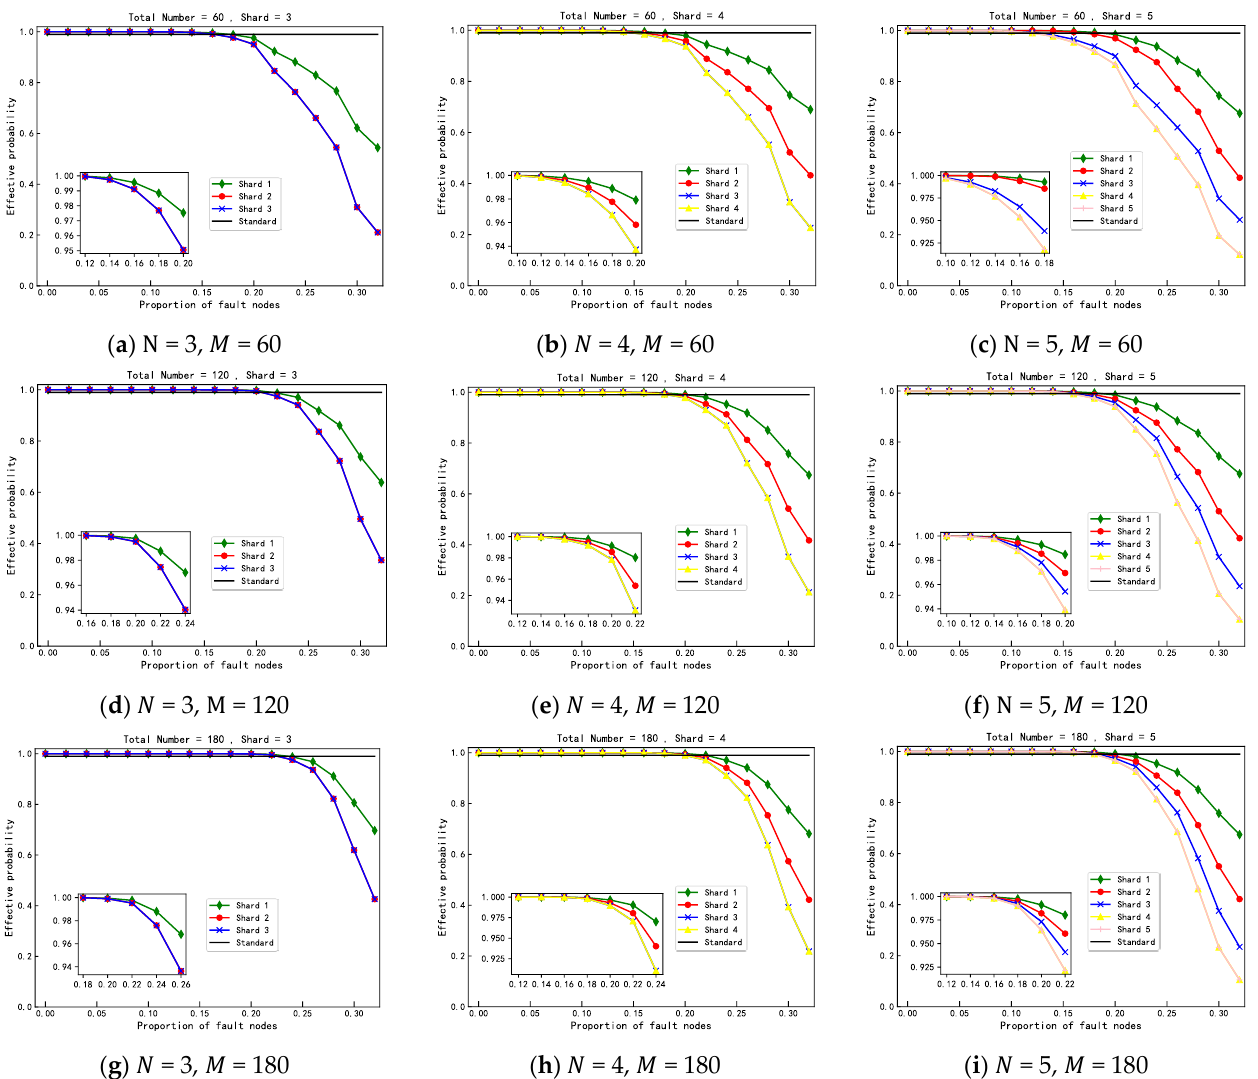
Figure 9. 𝑁, 𝑀 impact on individual shard validity.Among which 𝑁 represents the number of Figure 9. N , M impact on individual shard validity. Among which N represents the number of shards shards and 𝑀 represents the total number of the nodes. and M represents the total number of the